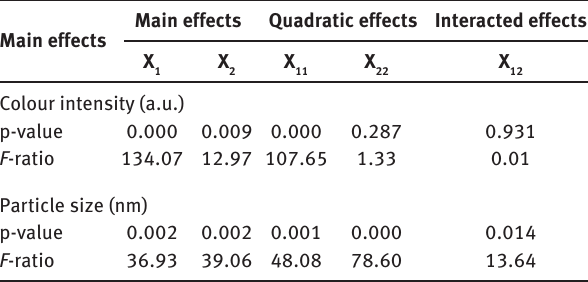
Figure 1: FT-IR spectrum of Aloe vera leaf extract.